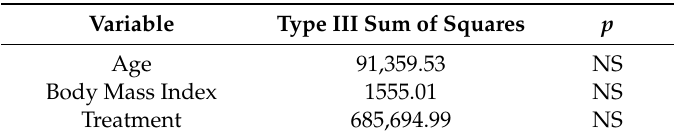
Table 7. Dependent variable: newborn weight (kg). ANCOVA analysis. R Squared = 0.116 (Adjusted R Squared = −